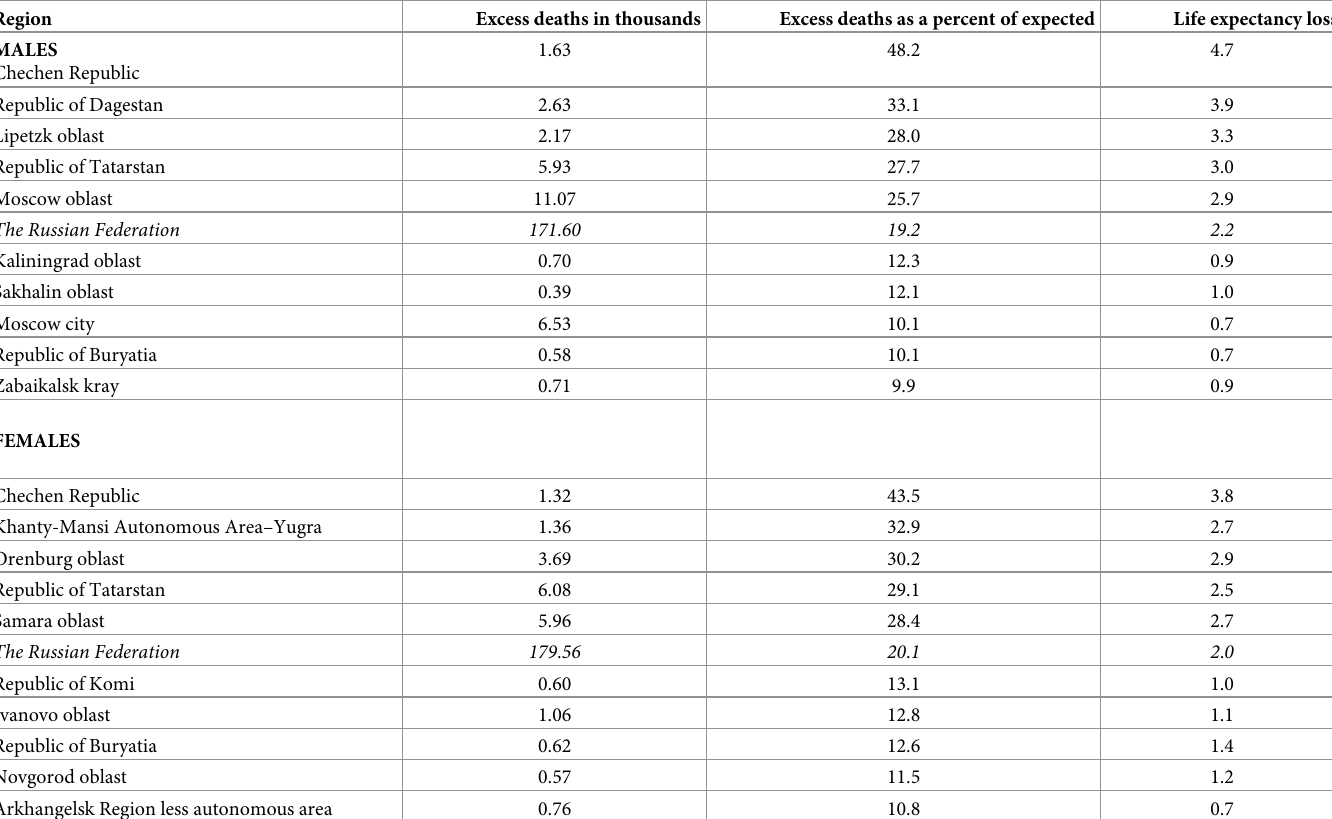
Table 3. Expected, observed and excess deaths (expressed in absolute and percentage terms), highest and lowest five regions of the Russian Federation with greater than 3,000 predicted deaths per year, 2020, males and females.